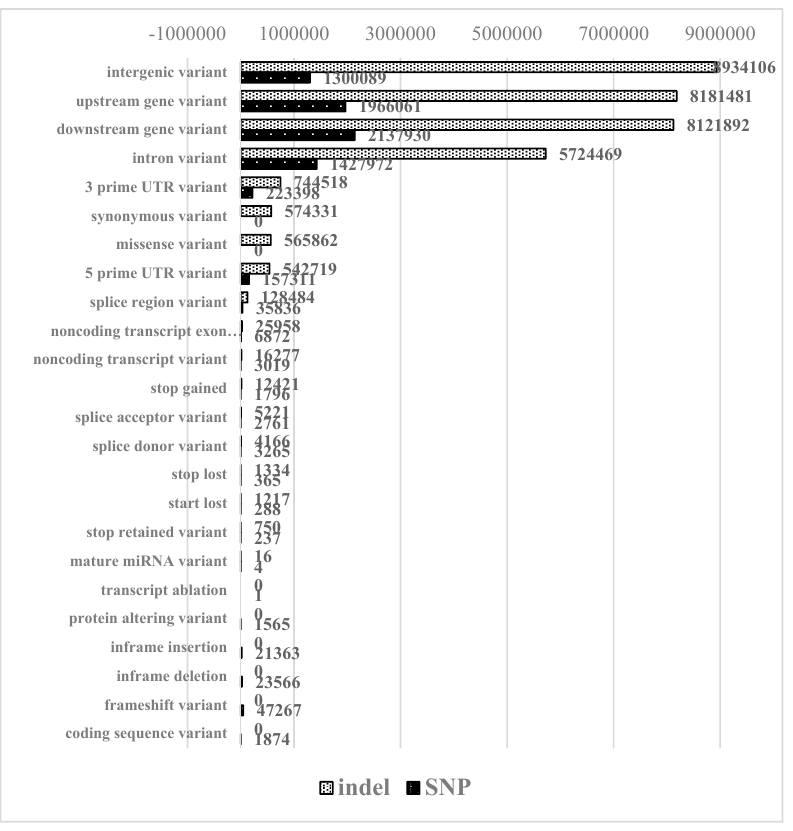
Figure 2. Predicted high impact consequences of identified indels and single nucleotide polymorphisms (SNPs).